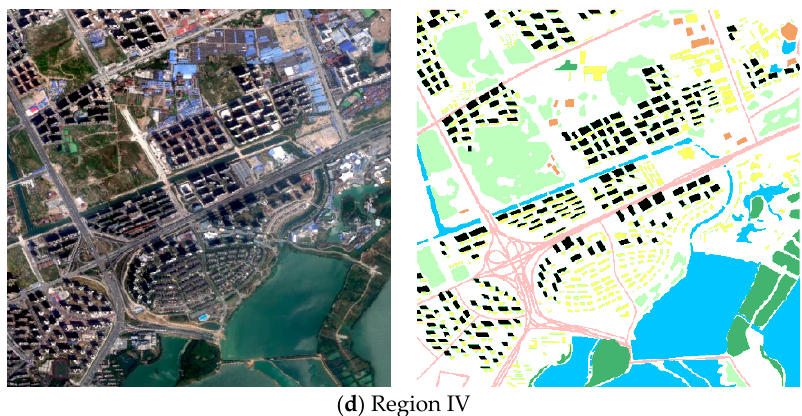
Figure 3. Images (left) and ground truth annotations (right) of the four test regions (yellow = buildings, blue = water, dark green = forests, light green = grasses, pink = roads, orange = soils, and black = shadows). Table 2. Number of testing samples for each class in the test regions.